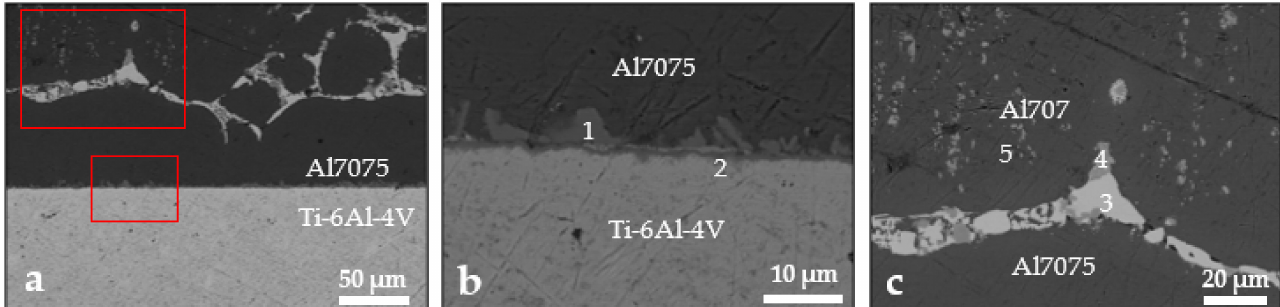
Figure 3. Microstructure of the Al7075/Ti-6Al-4V interface with Cu interlayer at 520 ◦ C, holding pressure of 10 MPa, and holding time of 10 min at ( a ) low magnification at the joint region, at higher magnification ( b ) at the joint region, and at ( c ) diffused copper in the Al side. The magnified areas in ( b , c ) are shown as red rectangles in ( a